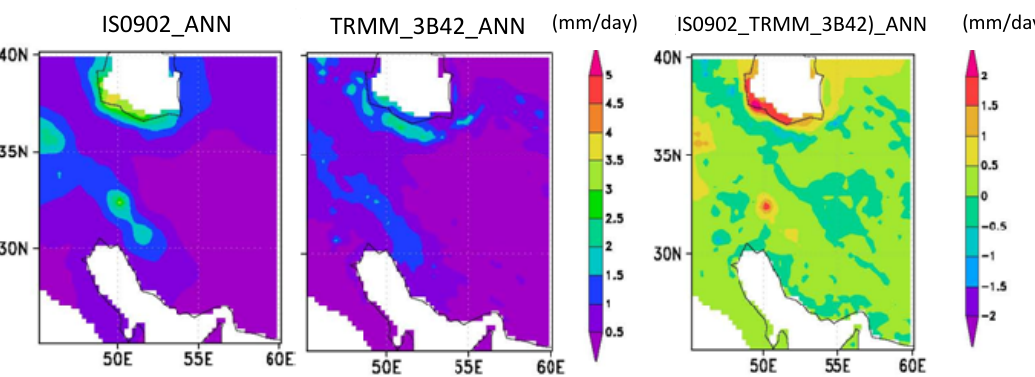
Fig. 5. Comparison of mean annual precipitation in IS0902 (0.25°×0.25°) and TRMM_3B42 (0.25°×0.25°) for the time period 1998-2006. (a) IS0902 (mm day -1 ) and (b) TRMM_3B42 (mm day -1 ), (c) Difference in mean annual precipitation between IS0902 and TRMM_3B42 (mm day -1 ). ANN = annual.